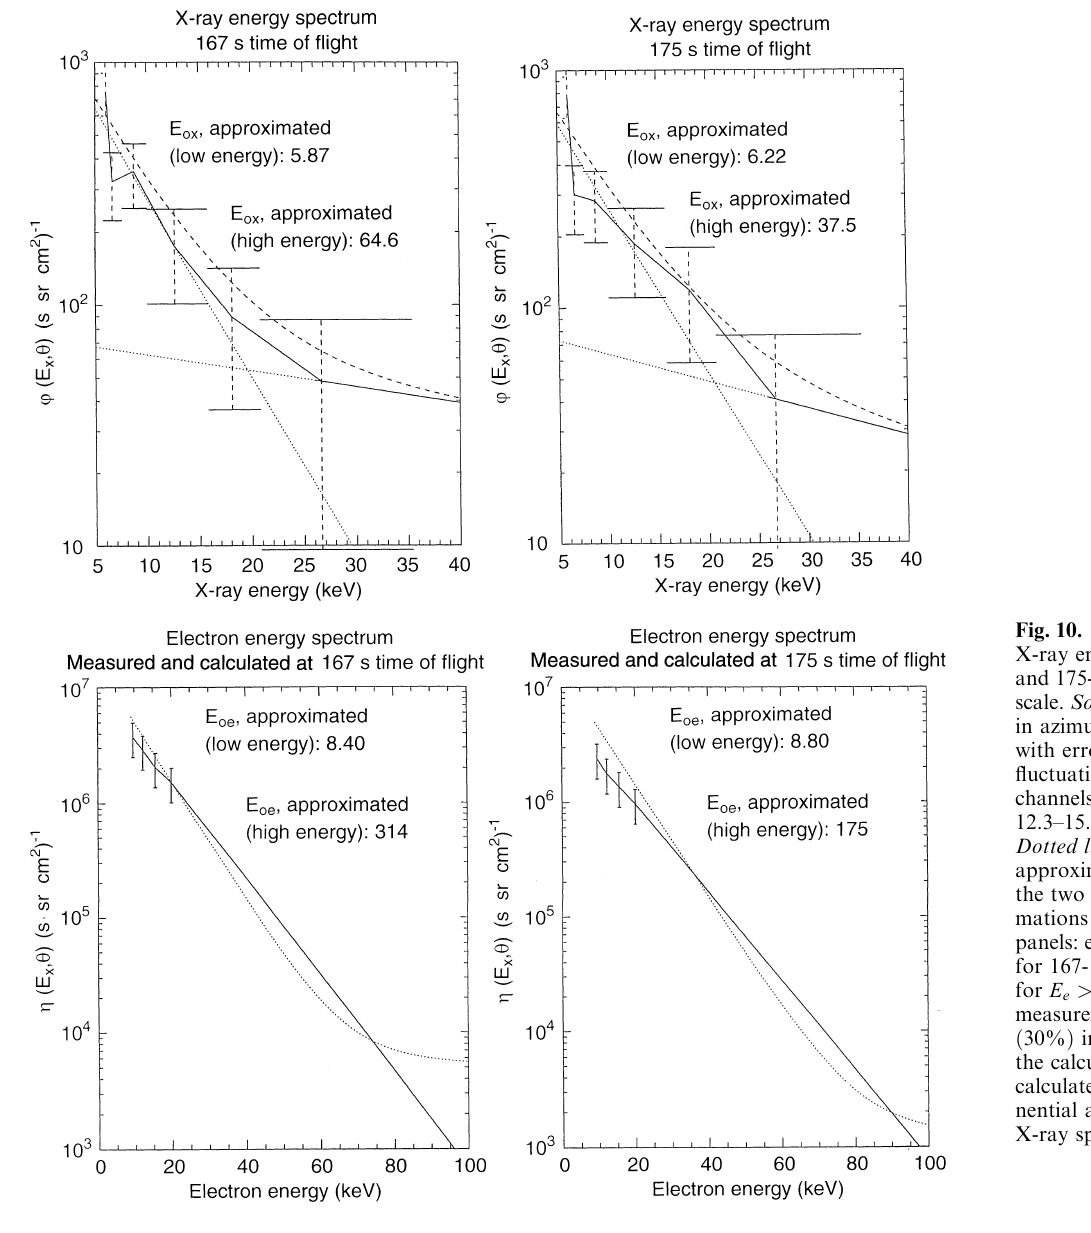
Fig. 10. The two upper panels: X-ray energy spectra for 167- and 175-s flight time, in lin-log scale. Solid line : measurements in azimuth sector 0 (cid:14) to 30 (cid:14) , with error bars (statistical fluctuations) indicated. The channels 10.0–12.3 keV and 12.3–15.8 keV are added. Dotted line : two exponential approximations. Dashed line : the two exponential approxi- mations added. The two lower panels: electron energy spectra for 167- and 175-s flight time for E e > 10 : 8keV. Solid line : measurements, with error bars (cid:133) 30% (cid:134) indicated. Dotted line : the calculated electron spectra calculated from the two-expo- nential approximations of the